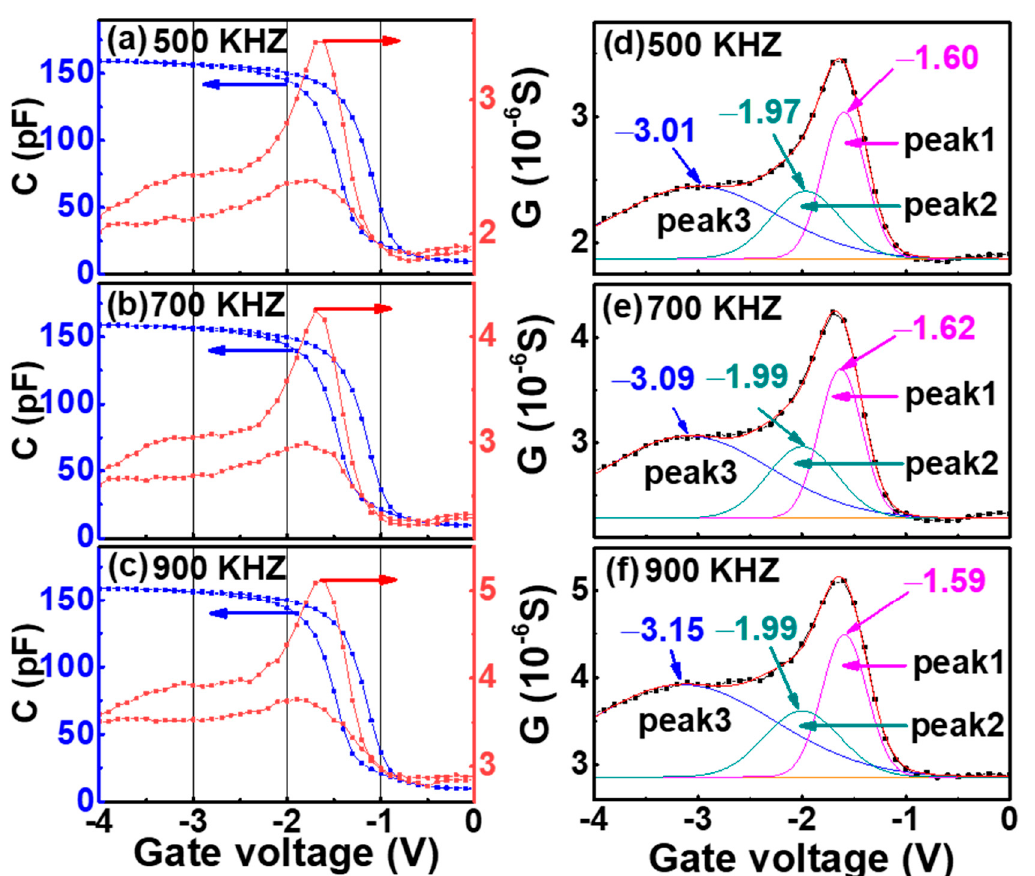
Figure 5. The G-V and C-V characteristic of the double-layer nc-Si floating-gate MOS structure under the frequency of ( a ) 500 KHZ, ( b ) 700 KHZ, and ( c ) 900 KHZ. The G-V curve is fitted by three Gaussian peaks of the annealed double-layer device at ( d ) 500 KHZ, ( e ) 700 KHZ, and ( f ) 900 KHZ. The blue lines represent the C-V curves, the red lines represent the G-V curves and the black lines represent the base line.